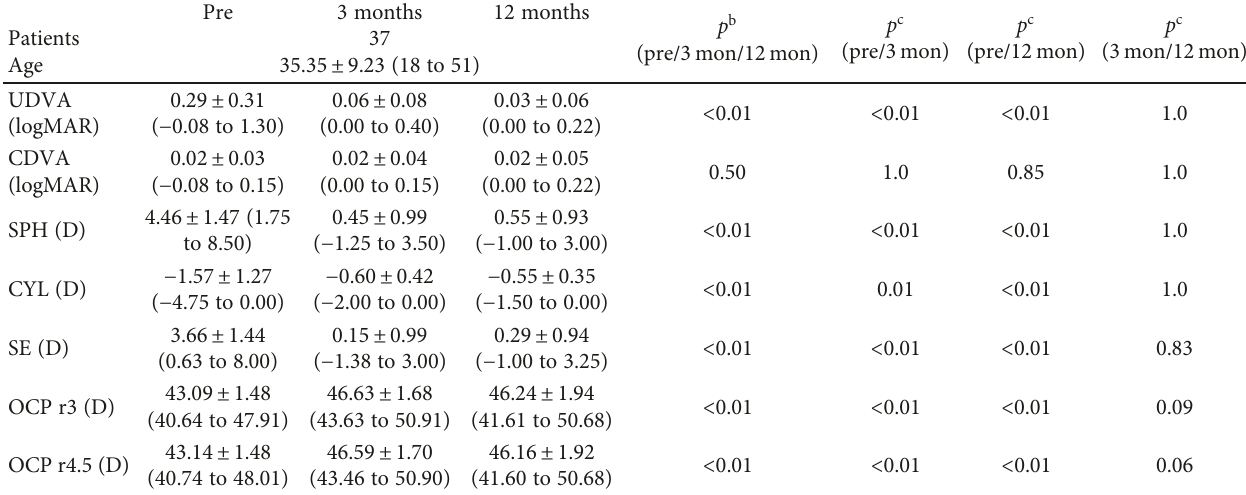
Table 1: Preoperative and postoperative visual, refractive, and objective outcomes 12 months after hyperopic LASIK a,b,c .